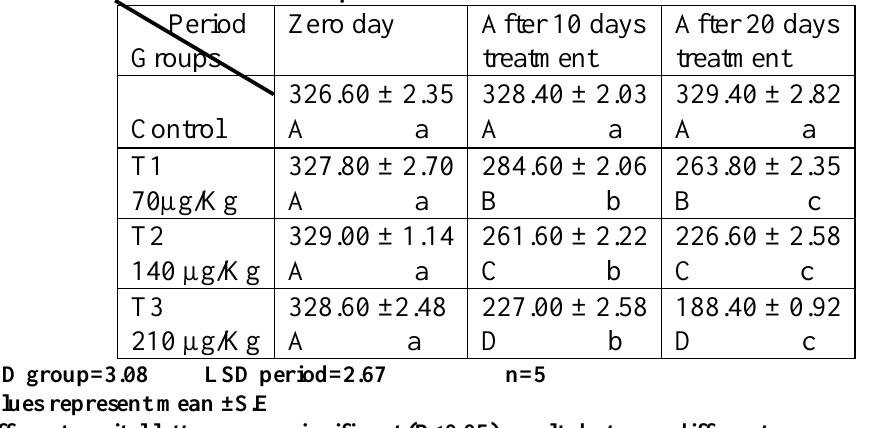
Table (3): ALP (I.U/L) in rats serum of different experimental groups dosed orally with ochratoxin A at different doses and periods.